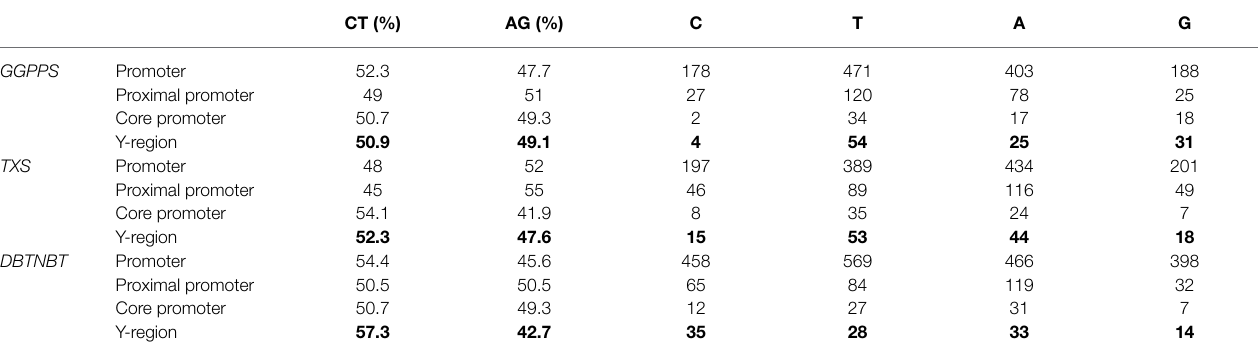
TABLE 2 | Pyrimidine and purine percentage and single nucleotide composition of GGPPS , TXS , and DBTNBT promoters.